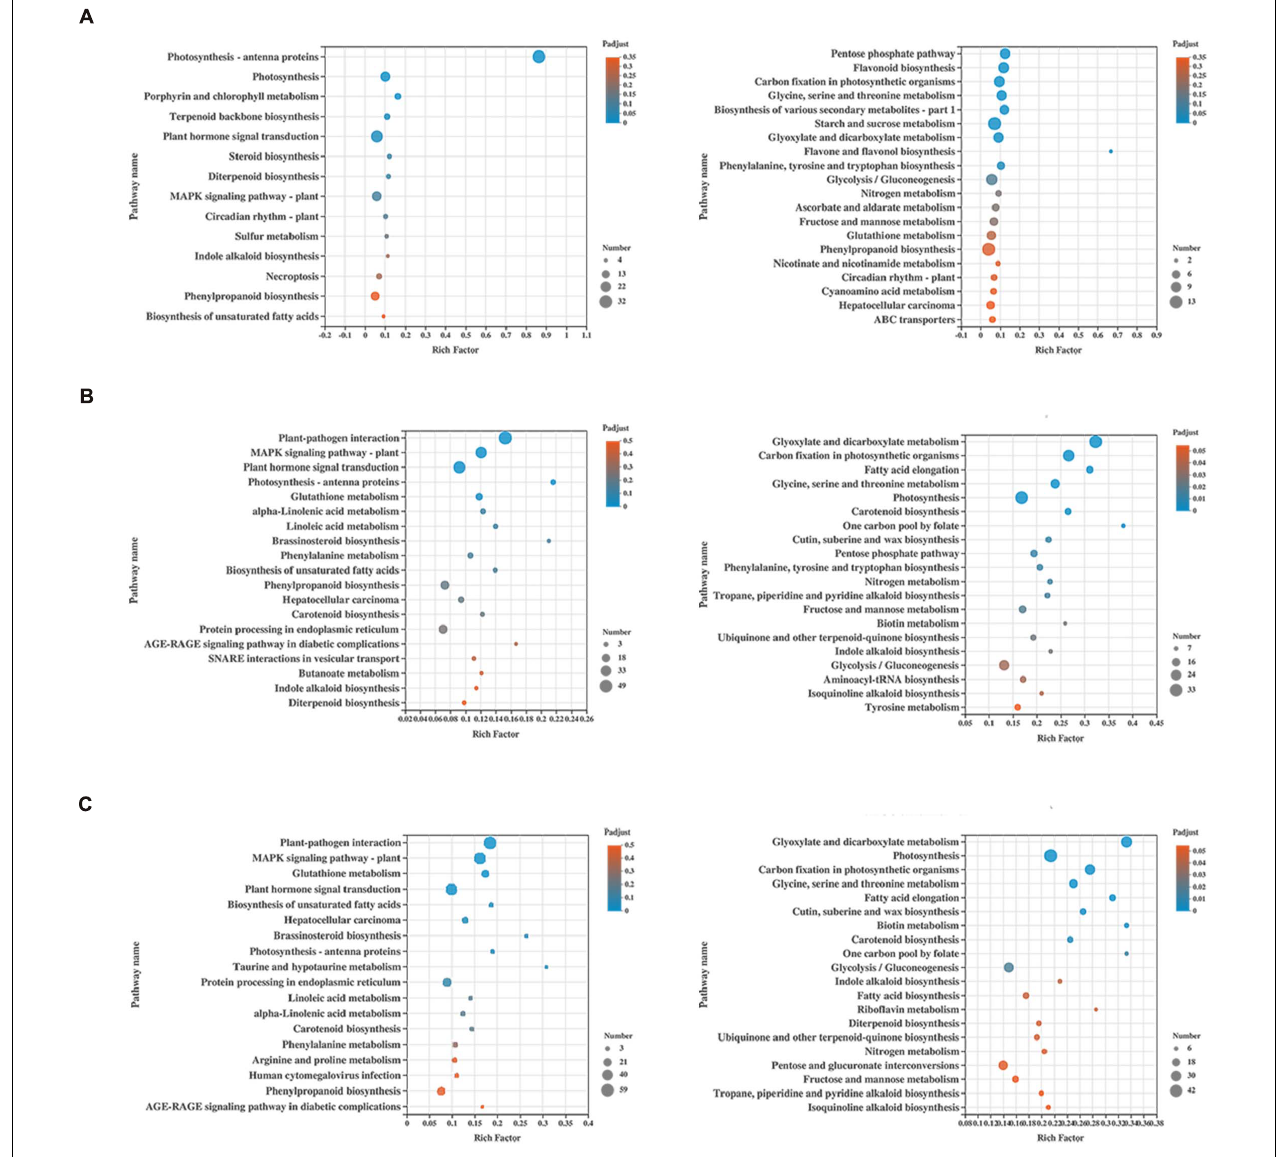
FIGURE 4 | KEGG enrichment analysis of the differentially expressed genes (DEGs) in tomato plants. (A) KEGG enrichment analysis of H_vs_HQ. (B) KEGG enrichment analysis of H_vs_V. (C) KEGG enrichment analysis of H_vs_VQ. The left and right show the enrichment of up- and down-regulated genes, respectively. H, healthy tomato plants. HQ, tomato plants was fed on by healthy B. tabaci for 24 h. V, tomato plants was inoculated with ToCV. VQ, tomato plants with ToCV that were fed on by healthy B. tabaci for 24